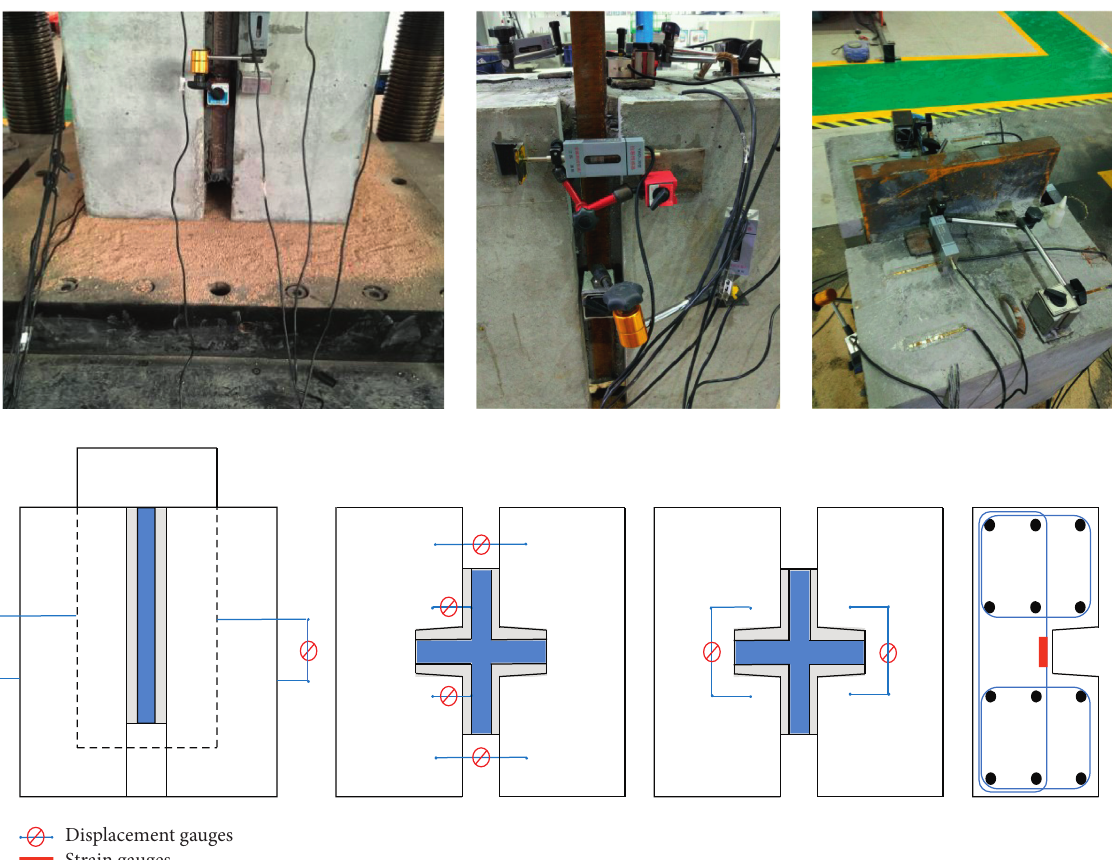
Figure 11: Test setup and